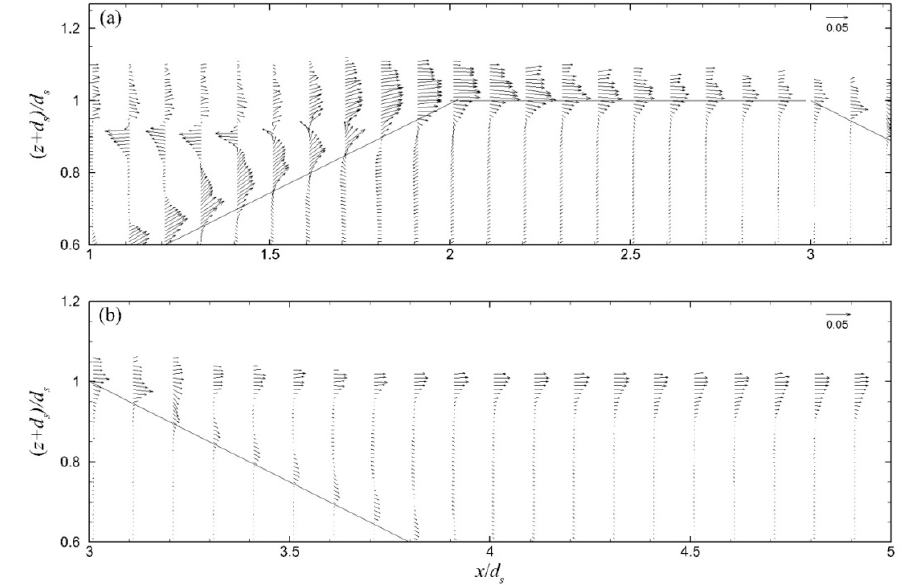
Figure 12. Period-mean velocity field for ZFB case 4 in: ( a ) the seaward region, and ( b ) the leeward region. Velocity vectors are shown non-dimensionalized by ( gd S ) 1/2 in the water phase under the wave crest envelope.